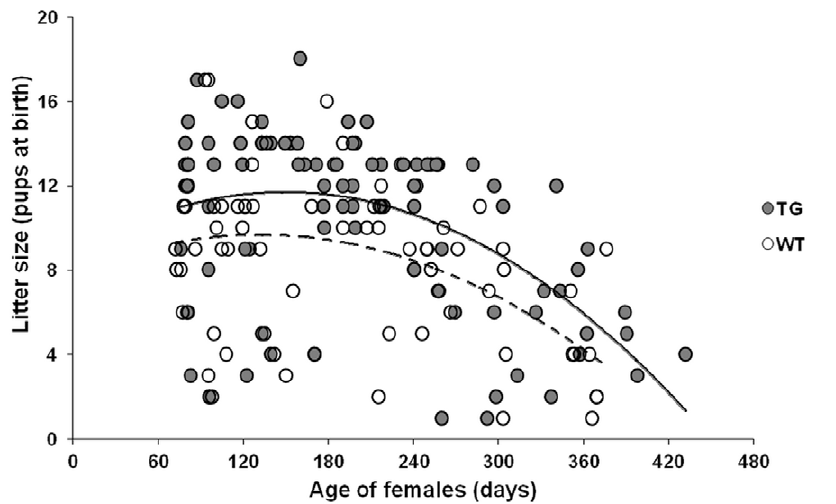
Figure 5. Reproductive performance of TG females. Fertility data on liveborn pups from TG ( n =15) and WT ( n =15) female mice up to 450 days of age; the number of litters per mouse was approximately six. Total pups per litter plotted against age of female on the day of birth showing comparable breeding curves for the TG (solid line) and WT (dashed line) females. The results of the analysis of each of the two separate lines were found to be comparable to that of the combined analysis.